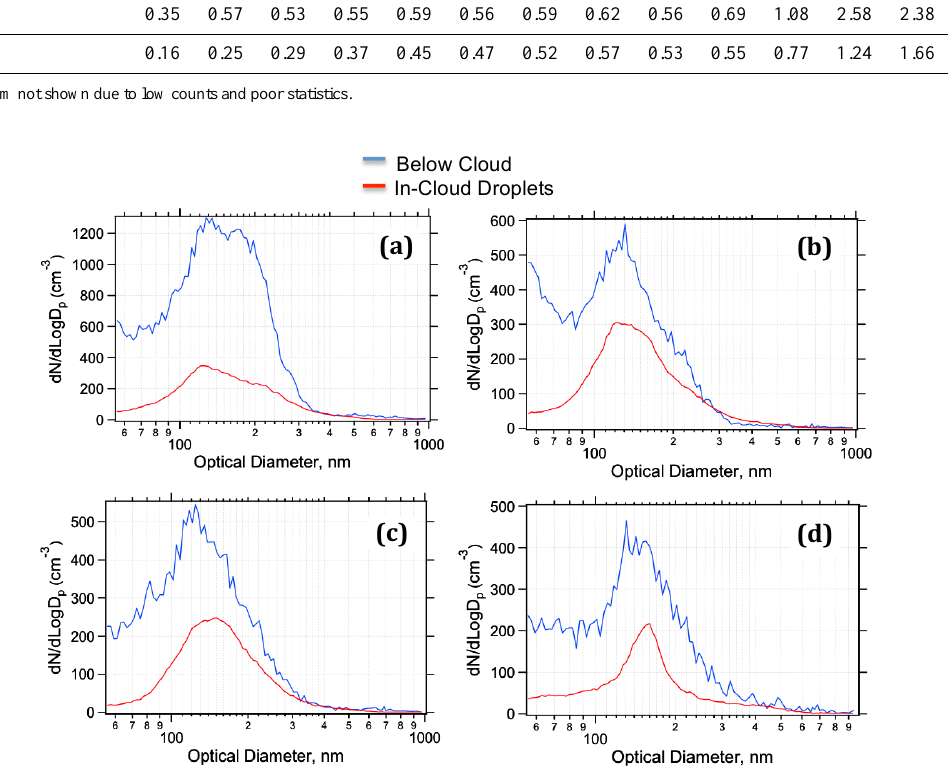
Fig. 10. UHSAS particle size distributions for four sets of paired below-cloud (blue) and in-cloud droplets (red) for CVl samples in clouds with drizzle < 5L − 1 and ratio of CVI total number concentration to droplet number concentration between 0.72 and 0.94. C-130 flights and in-cloud UTC times are (a) flight 2 (18 October 2008): 13:33:32–13:36:58, (b) flight 3 (21 October 2008): 07:18:25–07:24:40, (c) flight 3 (21 October 2008): 13:14:15–13:16:40, and (d) flight 11 (9 November 2008): 16:42:42–16:47:22. In-cloud distributions are less noisy than below-cloud distributions due to the enhancement factor in the CVI